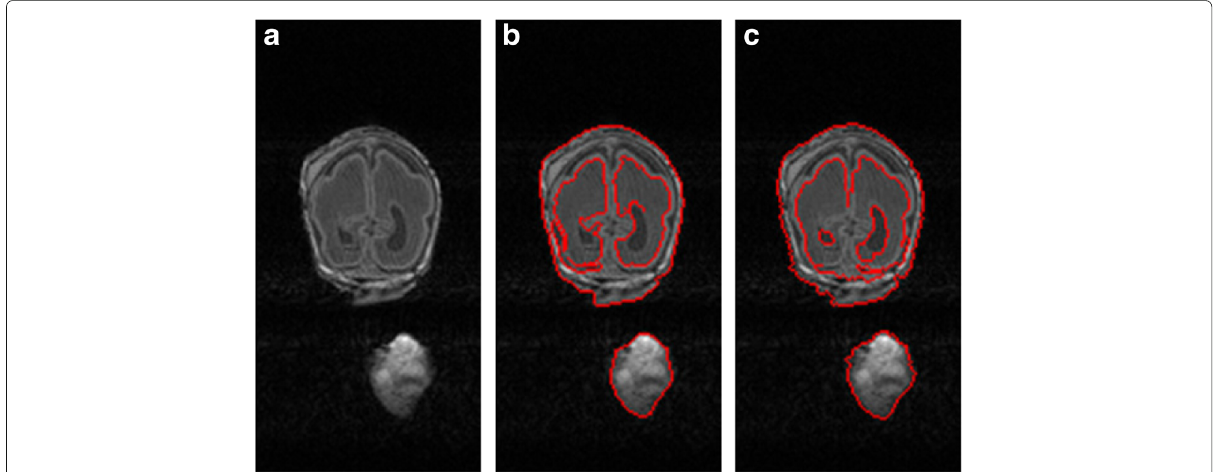
Fig. 11 Comparison with [31]: a the 84th MR image, b the result via [31], and c the result based on our